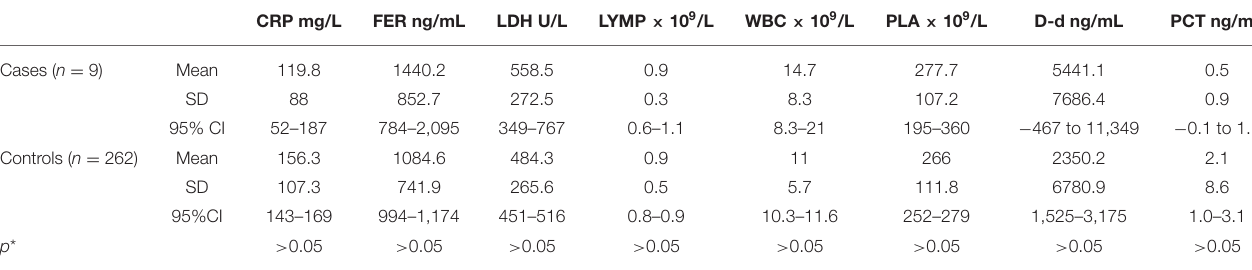
TABLE 5 | Inflammatory biomarkers from cases and controls.